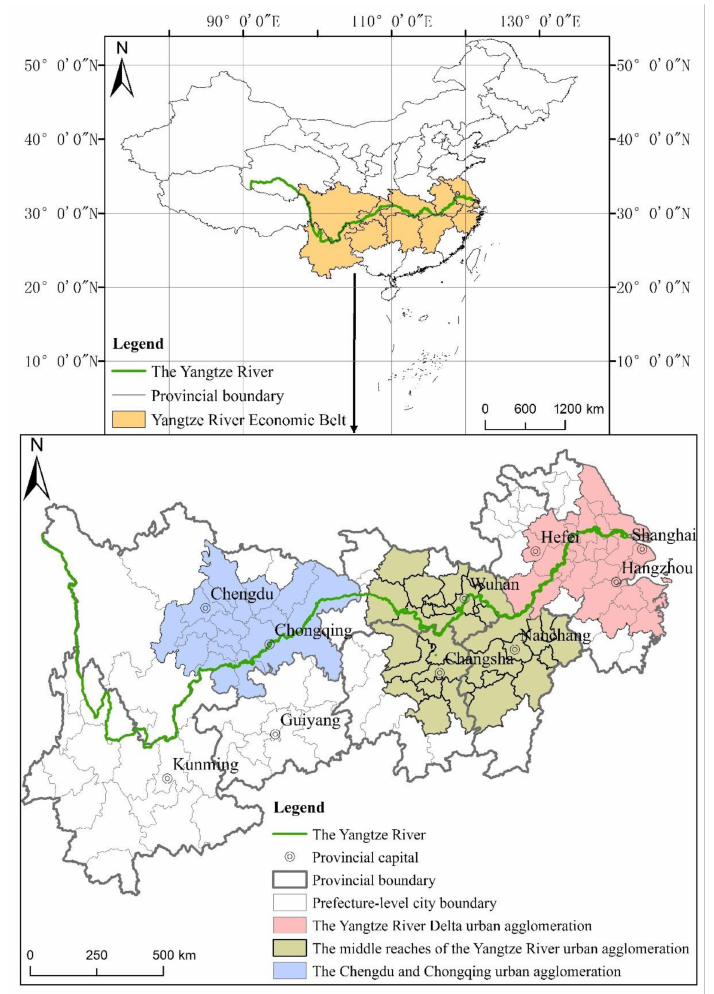
Figure 1. Location introduction map of YREB and its three major urban